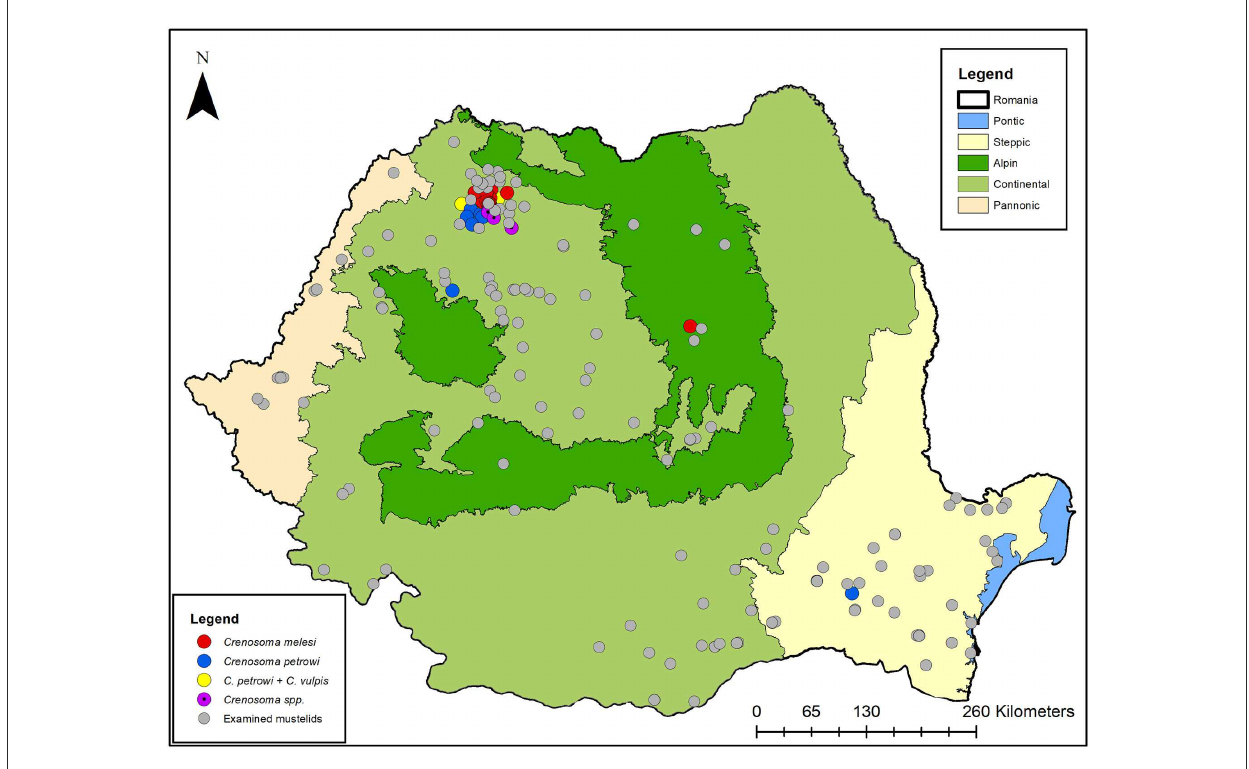
FIGURE6 The distribution map of Crenosoma spp. in Romanian